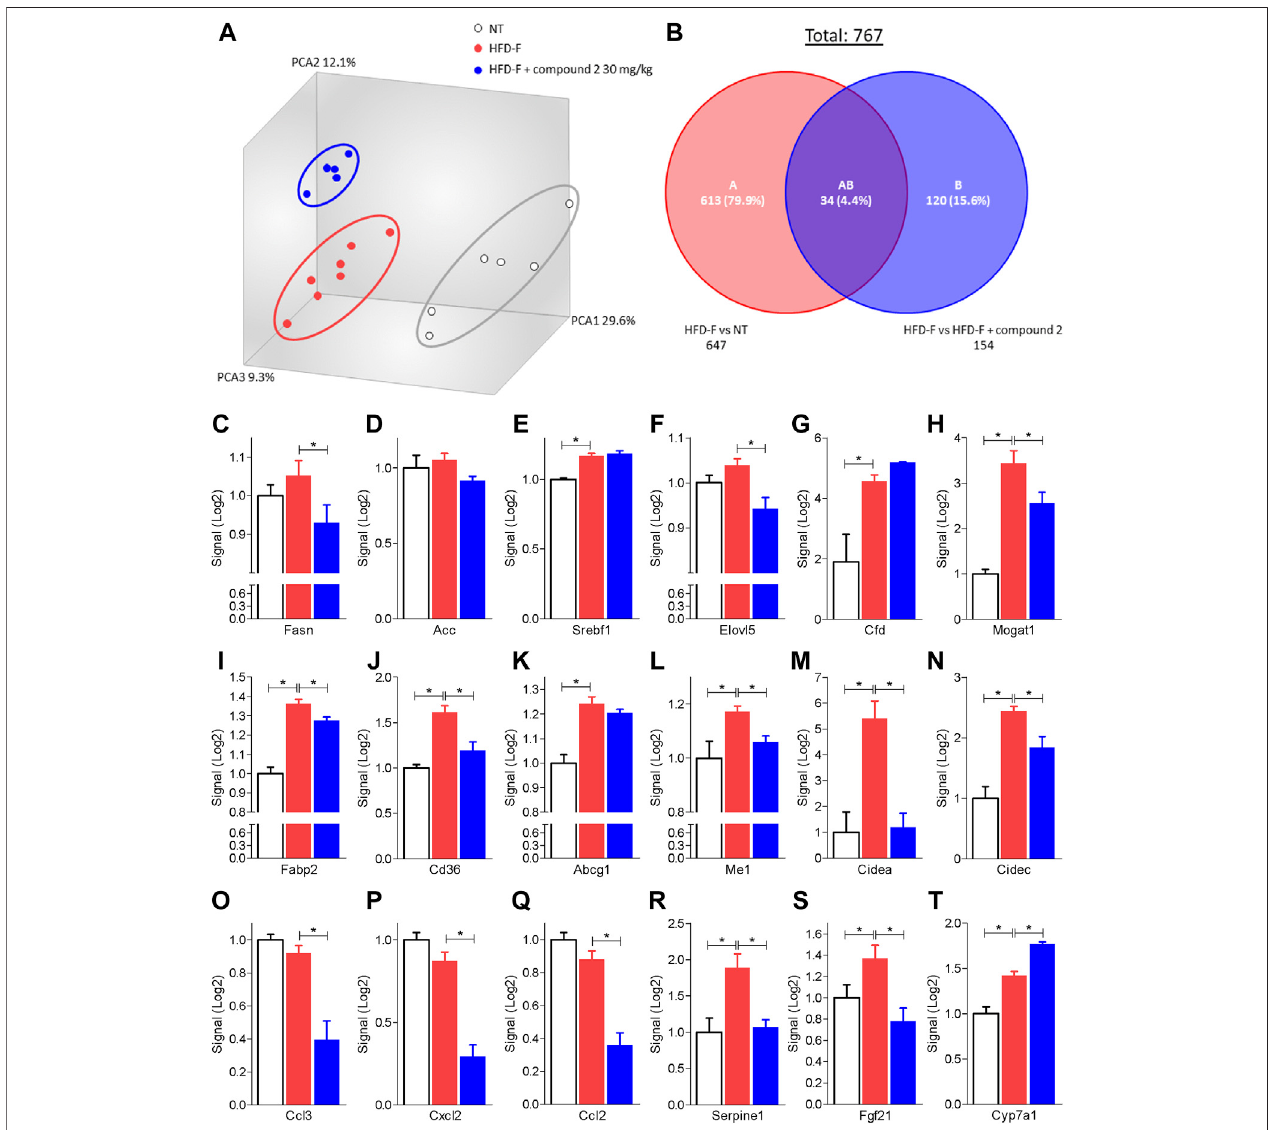
FIGURE 7 | Liver transcriptome analysis of compound 2 in mice feed a HFD-F. C57BL/6 male mice were fed a high fat diet and fructose (HFD-F) or normal chow diet for 61 days.Fromday7compound2wasadministeredbyoralgavageatthedoseof30 mg/kg/daily. (A) Quantitative β analysisofPCoAthatshowedamajordissimilaritybetween thethreeexperimentalgroupand (B) Venndiagramofdifferentiallyexpressedgenesshowingtheoverlappingregionsbetweentheexperimentalgroups(foldchange < − 2or > 2, p value < 0.05).RelativemRNAexpressionlevelsextractfromRNA-seqanalysisof: (C) Fasn, (D) Acc, (E) Srebf1, (F) Elovl5, (G) Cfd, (H) Mogat, (I) Fabp2, (J) Cd36, (K) Abcg1, (L) Me1, (M) Cidea, (N) Cidec, (O) Ccl3, (P) Ccl2, (Q) Cxcl2, (R) Serpine1, (S) Fgf21 and (T) Cyp7a1. Results are the mean ± SEM of 5-7 mice per group; * p <